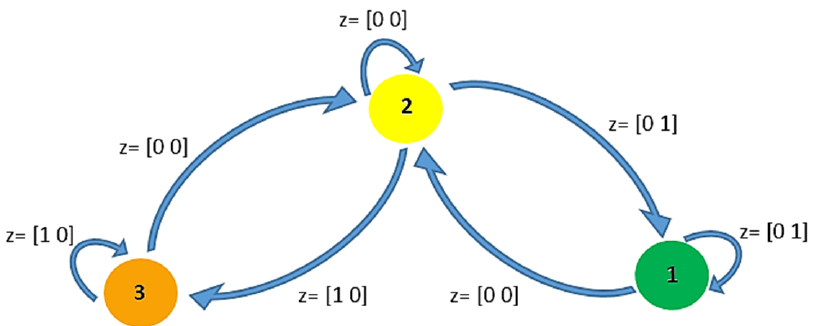
Figure 3. Transition states among green, yellow, and orange as threshold levels, perceiving z = [ z n z m ] as the internal and external